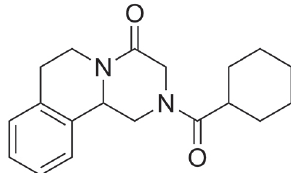
FIGURE 1 – Chemical structure of